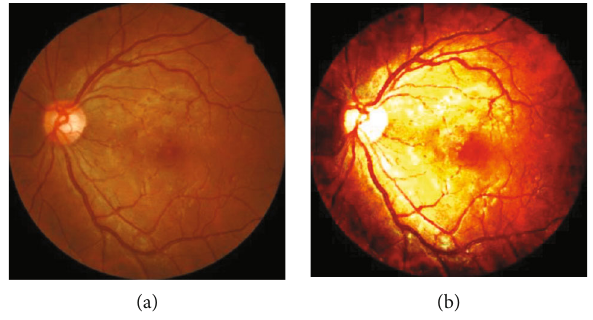
Figure 1: Fundus image after (a) cropping and (b) normalization.